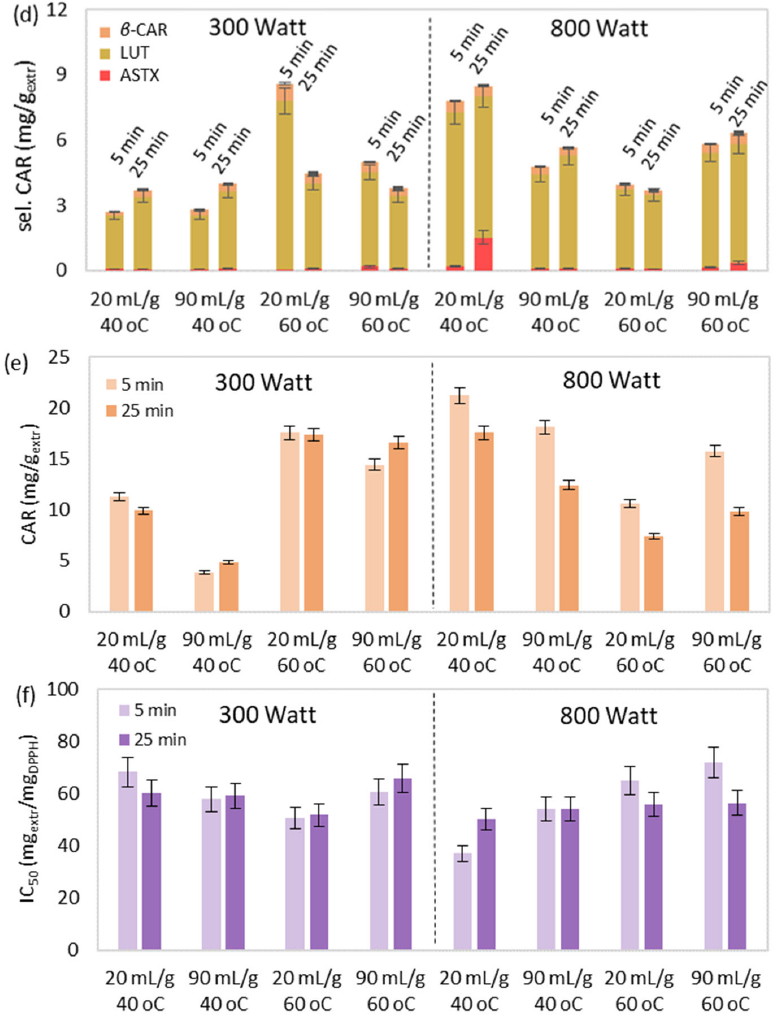
Figure 5. The simultaneous effect of extraction temperature, duration, solvent ‐ to ‐ biomass ratio, and microwave power on MAE’s ( a ) yield, extract’s total ( b ) phenolic and ( c ) chlorophyll content, ( d ) selected and ( e ) total carotenoid content, and ( f ) antioxidant